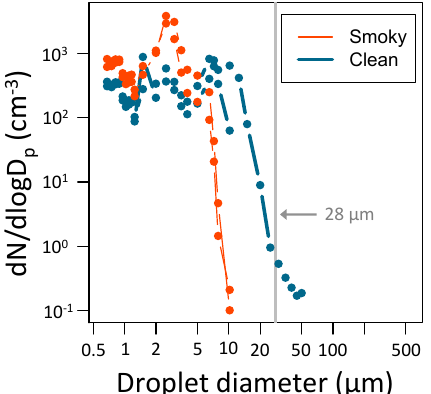
Figure 6. Mean cloud droplet size distributions (µm) for individ- ual case study biomass burning clouds (thin orange lines) and clean background clouds (thick blue lines). The 28µm line is marked in